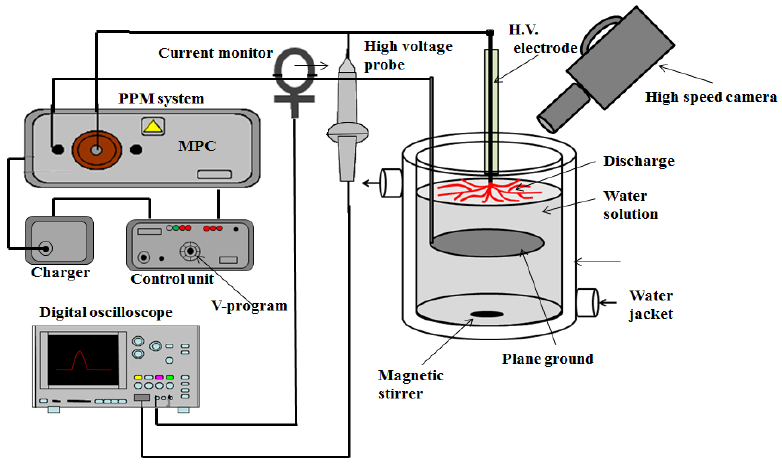
Figure 1. Schematic of the experimental setup to generate and evaluate the water surface discharge.